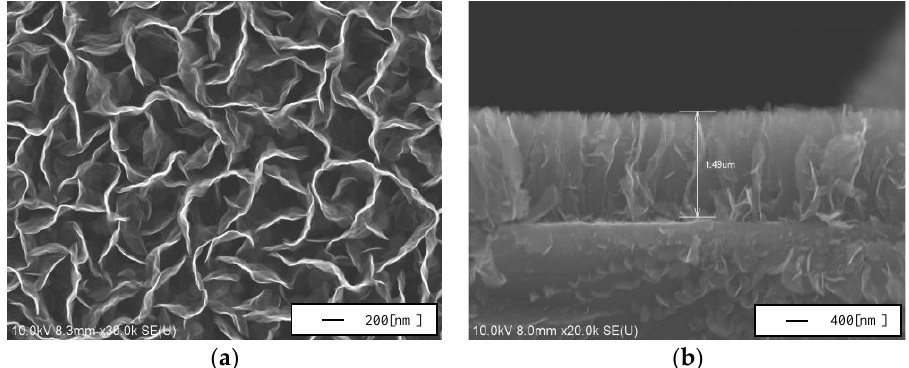
Figure 1. Scanning electron microscopy (SEM) image of carbon nanowall (CNW) on Si substrate; ( a ) plane view, ( b ) cross-sectional view.